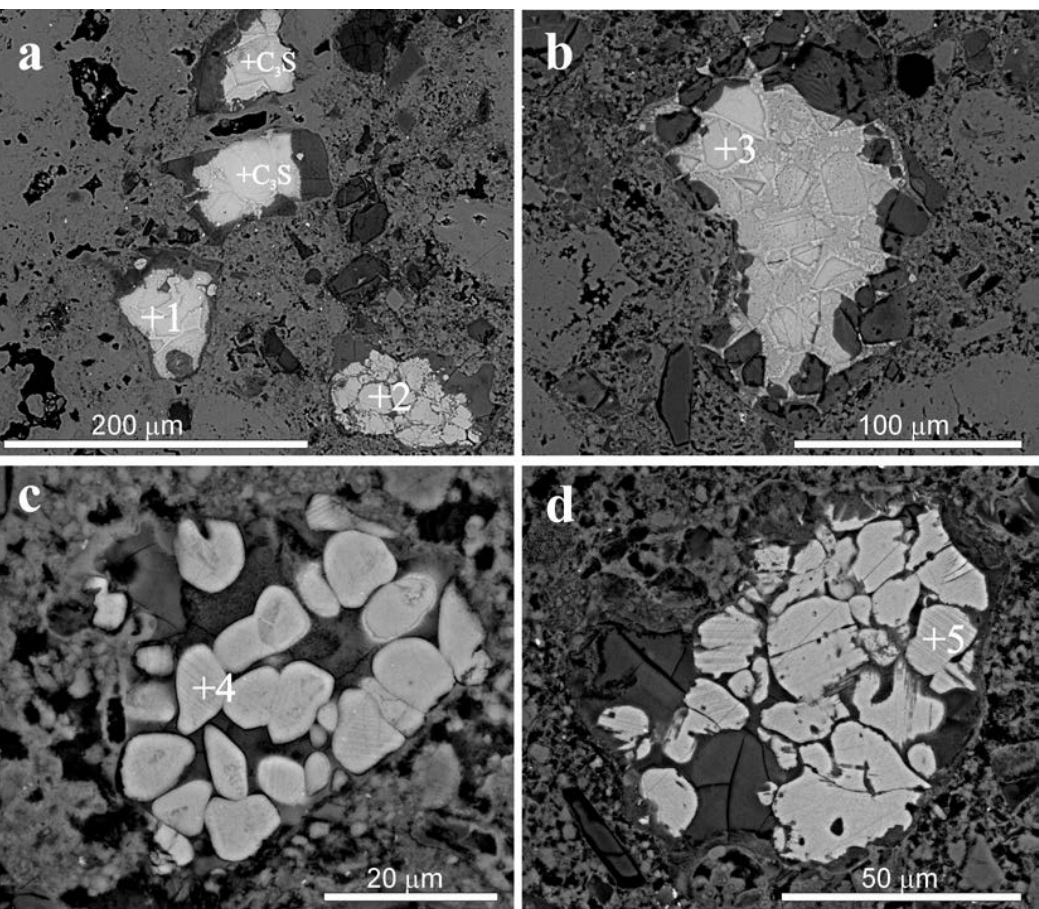
Figure 4. Backscattered (BSE) electron image of residual cement grains from sample KD-M-4-2: ( a ) Grain with coalescent C 3 S alite (+1) and belite C 2 S, revealing finger-like pattern (+2). The grains are surrounded by rim of inner hydration product; ( b ) Cluster of typical alite crystals (+3) surrounded by silica gel (carbonation product of C 3 S); ( c ) Small, rounded belite crystals with parallel lamellae ( + 4) in a hydrated matrix; ( d ) Subhedral belite crystals type II with lamellae ( + 5). For qualitative analyses of the phases, see Table 1.